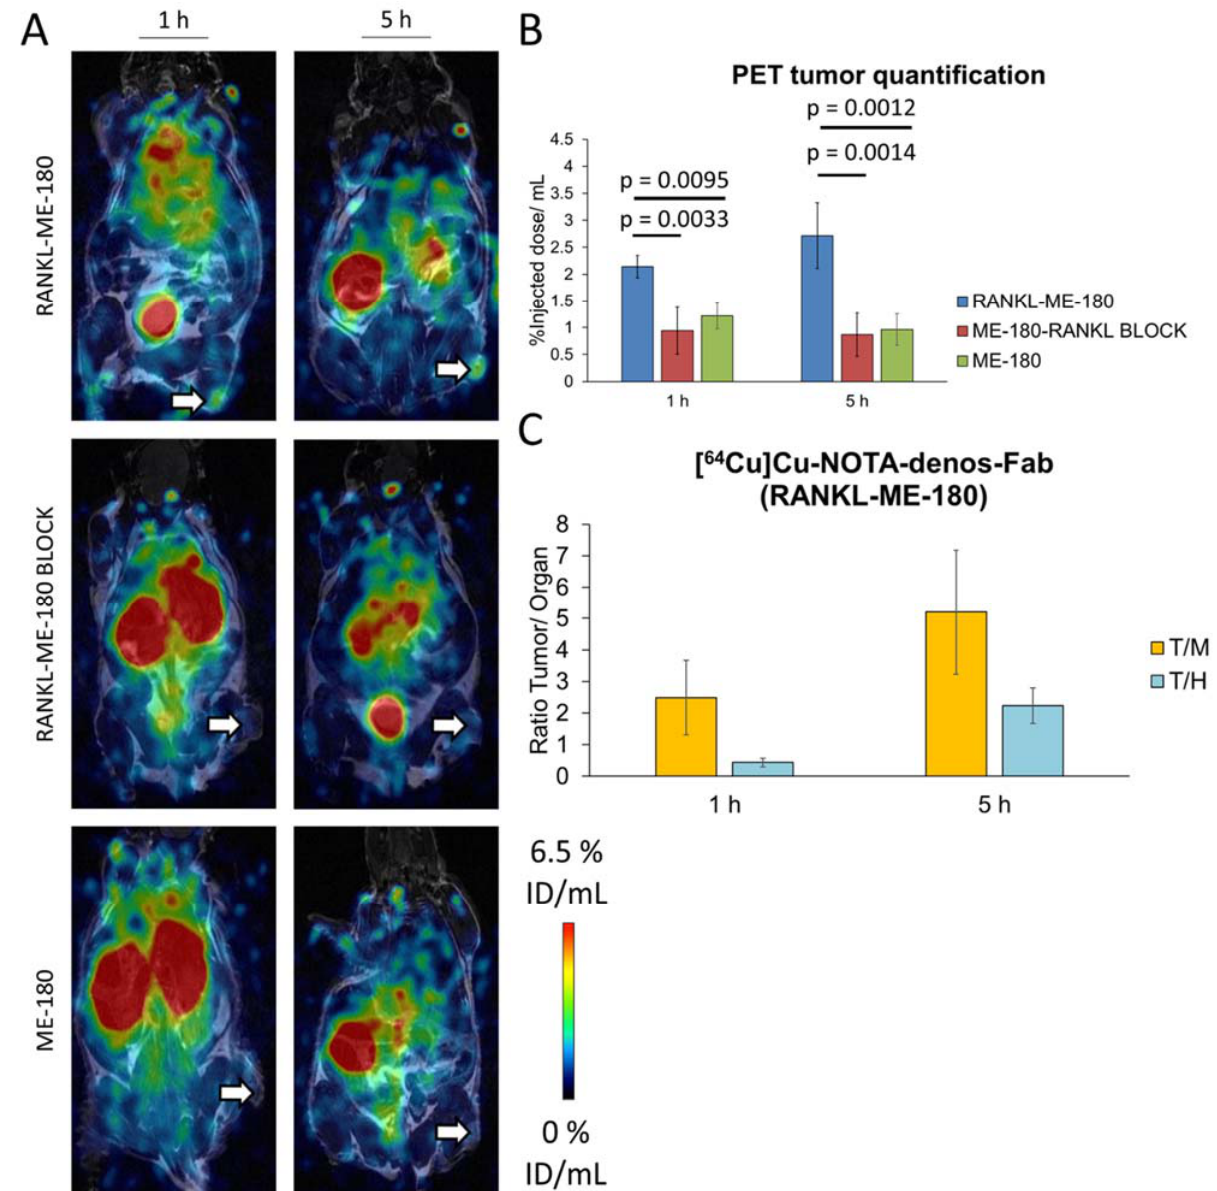
Figure 4. [ 64 Cu]Cu ‐ NOTA ‐ denos ‐ Fab PET imaging. ( A ) [ 64 Cu]Cu ‐ NOTA ‐ denos ‐ Fab PET images of RANKL ‐ ME ‐ 180 ( top ), RANKL ‐ ME ‐ 180 BLOCK ( middle ), and ME ‐ 180 ( bottom ) xenografts at 1 h and 5 h p.i. ( B ) PET analysis of [ 64 Cu]Cu ‐ NOTA ‐ denos ‐ Fab tumor uptake. ( C ) [ 64 Cu]Cu ‐ NOTA ‐ denos ‐ Fab tumor/background ratios in RANKL ‐ ME ‐ 180 xenografts. (ID/mL: injected dose/mL; data graph: mean ± 1 standard deviation; white arrow: tumor, T/M: tumor/muscle, T/H: tumor/heart) . To obtain a head ‐ to ‐ head comparison with the antibody, [ 64 Cu]Cu ‐ NOTA ‐ deno ‐ sumab was also evaluated in RANKL ‐ ME ‐ 180 and ME ‐ 180 xenografts. In the positive model, [ 64 Cu]Cu ‐ NOTA ‐ denosumab showed a radiotracer uptake of 0.75 ± 0.19% ID/mL at 1h, 1.82 ± 0.38% ID/mL at 5 h, and 6.88 ± 1.12% ID/mL at 24 h p.i. In the negative model radiotracer uptake was 0.67 ± 0.25% ID/mL ( p = 0.6166) at 1 h, 1.72 ± 0.63% ID/mL ( p = 0.7901) at 5 h, and 3.51 ± 0.54% ID/mL ( p = 0.0016) at 24 h p.i., showing only a statistically significant difference in radiotracer uptake at the 24 h p.i. timepoint (Figure 5A,B). More importantly, [ 64 Cu]Cu ‐ NOTA ‐ denos ‐ Fab showed a statistically significant increase in tu ‐ mor uptake compared with [ 64 Cu]Cu ‐ NOTA ‐ denosumab at 1 h ( p = 0.0002) and at 5 h p.i. ( p = 0.0452) in RANKL ‐ ME ‐ 180 xenografts.